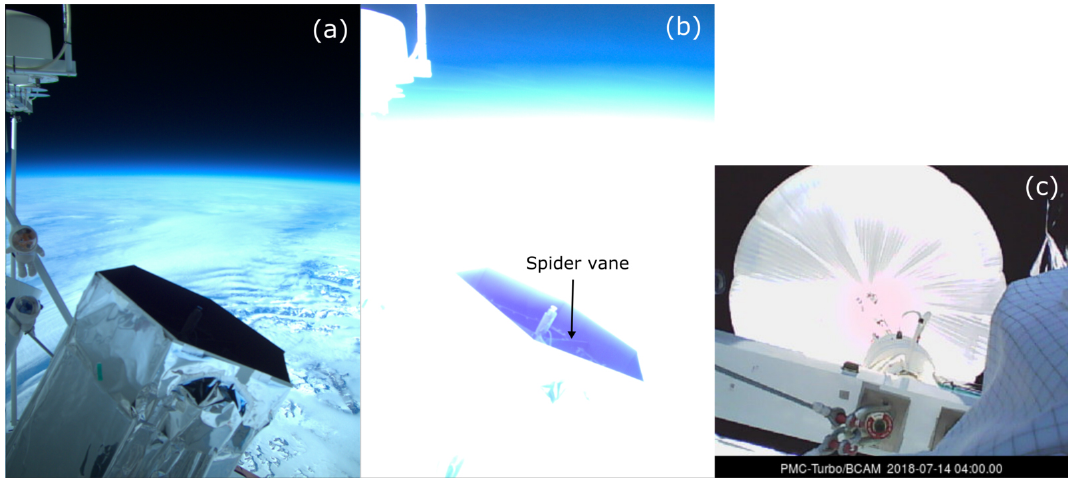
Figure 9. Normal (a) and overexposed (b) image of the upper part of the telescope taken by the side-viewing onboard camera. Panel (c) , taken by an upward-looking engineering camera inside the pressure vessel, shows the balloon above the